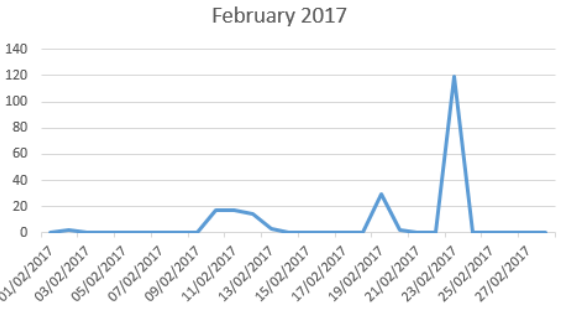
Figure 10. Daily precipitation Time Series of February